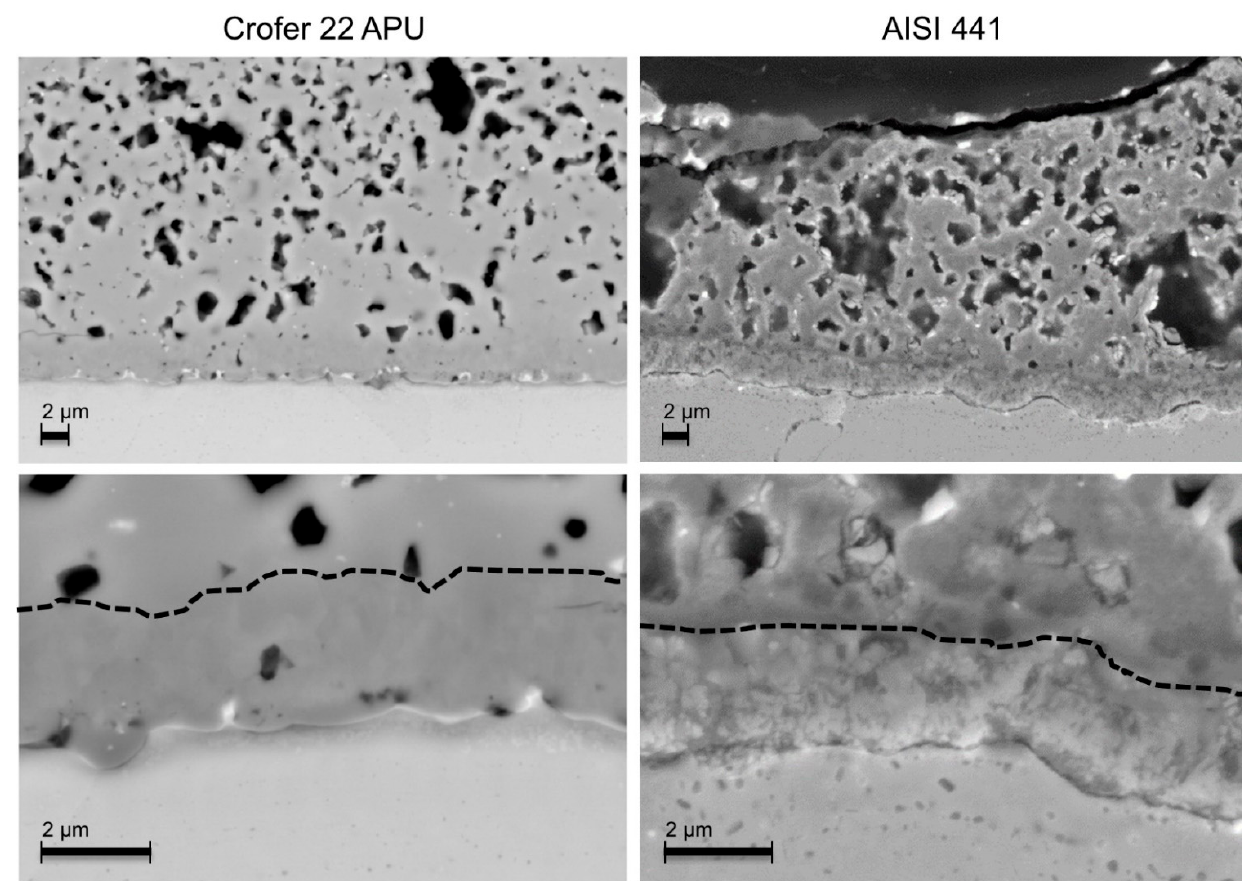
Figure 7. MCO coated Crofer 22 APU ( left ) and AISI 441 ( right ) after 1500 h at 800 °C in oxidizing atmosphere at 2500 × ( upper ) and 10,000 × ( lower ) magnifications. Dashed black lines approximately show the interface between the oxide scale and the MCO coating in the pictures at higher magnification.